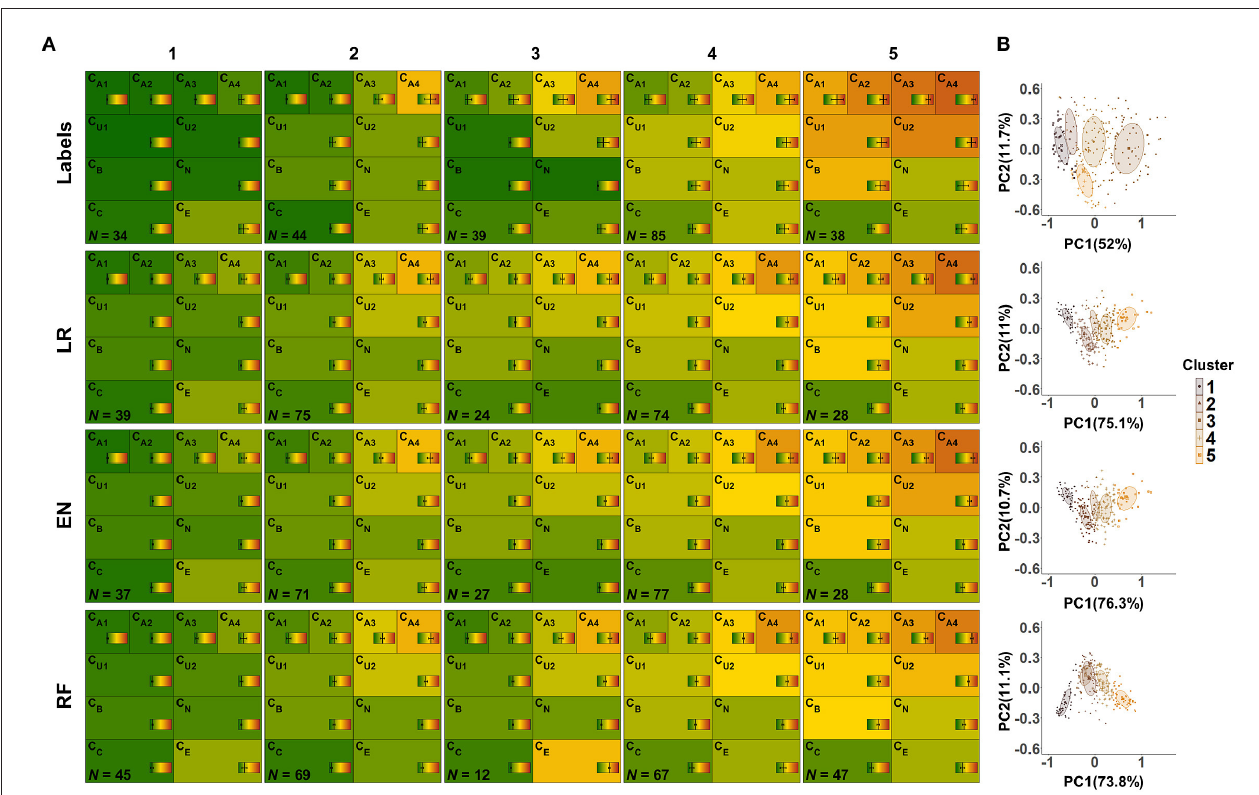
FIGURE 9 | CAFPA clusters estimated using model-based clustering. Rows depict the clusters for labeled CAFPAs (labeled data set), as well as the predicted CAFPAs for matched, unlabeled patients, originating from the models lasso regression (LR), elastic net (EN), and random forest (RF), respectively (unlabeled data set). (A) CAFPA patterns for five estimated clusters (columns). The average CAFPAs assigned to each cluster are depicted by the color of the respective area as well as by the vertical line in the color bar. Standard deviations are depicted by horizontal lines in the color bars. N indicates the number of patients assigned to each cluster. (B) Combined representation of the five estimated clusters. For visualization purposes, the clusters are displayed in the plane given by the first and second principal component (PC) estimated for the respective CAFPA data. The percentage of explained variance by PC1 and PC2 is indicated on the respective axis. Different colors of data points and two-dimensional Gaussian distributions correspond to the different clusters in the columns of (A)